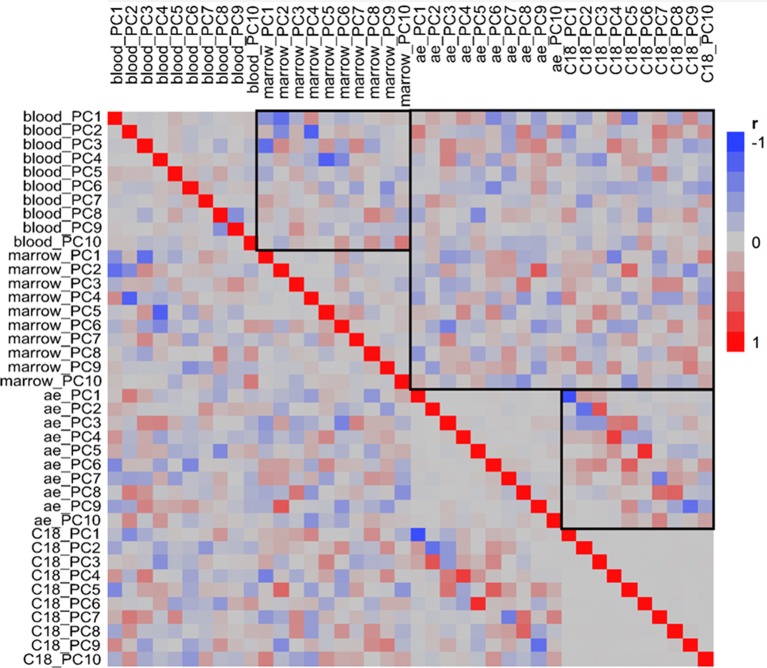
Pairwise correlation of principal components. Heatmap shows correlations of the first 10 principal components for each of the four omic datasets ordered by peripheral blood, bone marrow, AE and C18 (blue negative, red positive, stronger hues indicate stronger correlation). The highlighted boxes in the top left and bottom right quadrants show the correspondence between PC scores for the two transcriptomes and two metabolome columns, respectively; stronger colors along the diagonal indicate that those PC are capturing similar signals. Although there are scattered stronger colors in the top right quadrant comparing transcriptome and metabolome, the actual correlations are not significant.